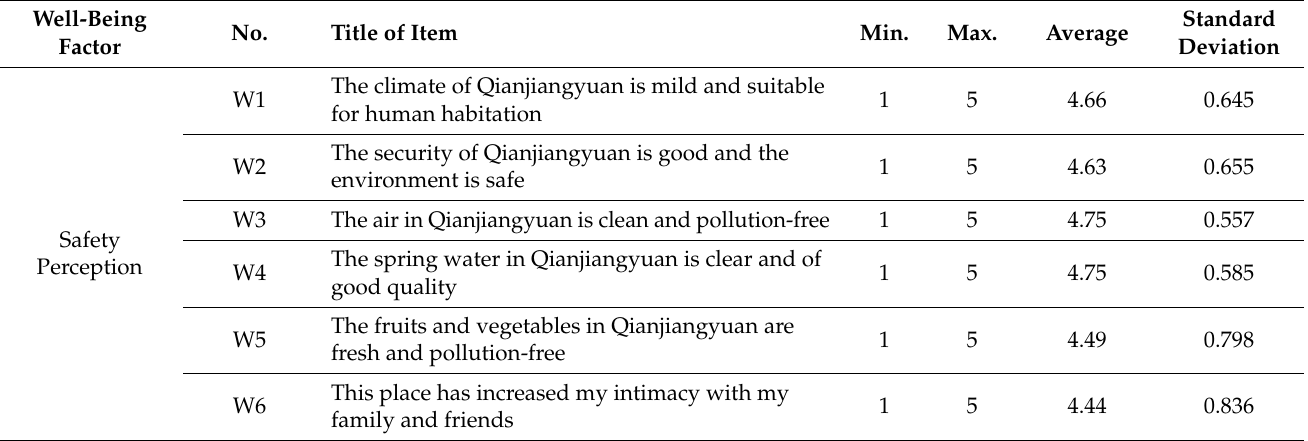
Table 1. The well-being scores of tourists in Qianjiangyuan National Park.